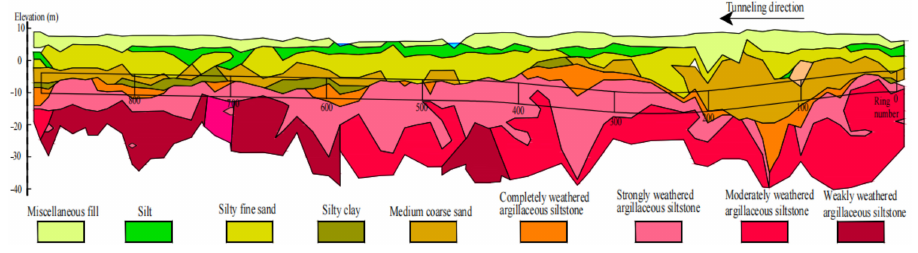
Figure 1. Geological profile along the shield tunneling section. Table 1. Physical and mechanical parameters of each